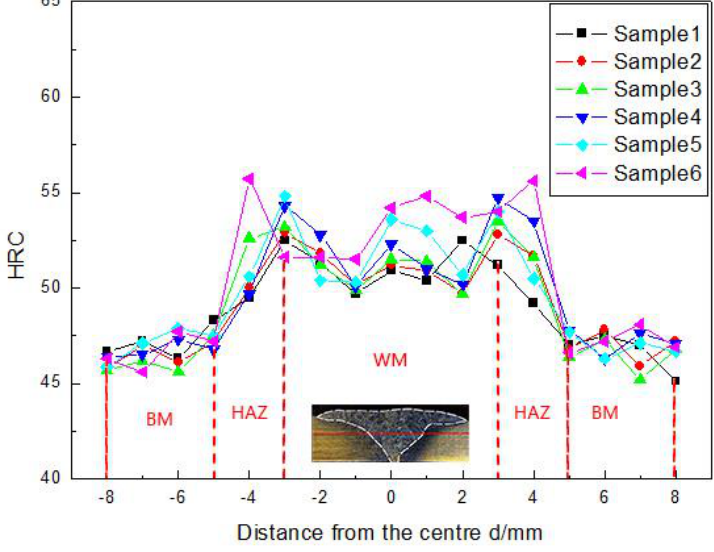
Figure 6. Rockwell hardness distribution in welded joints.